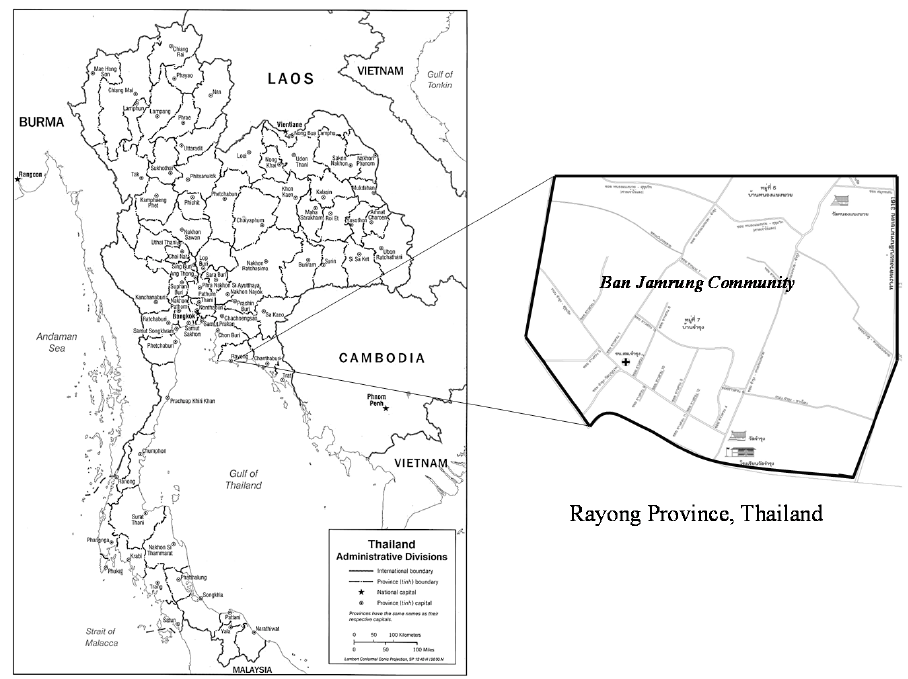
Figure 2. Study Area.